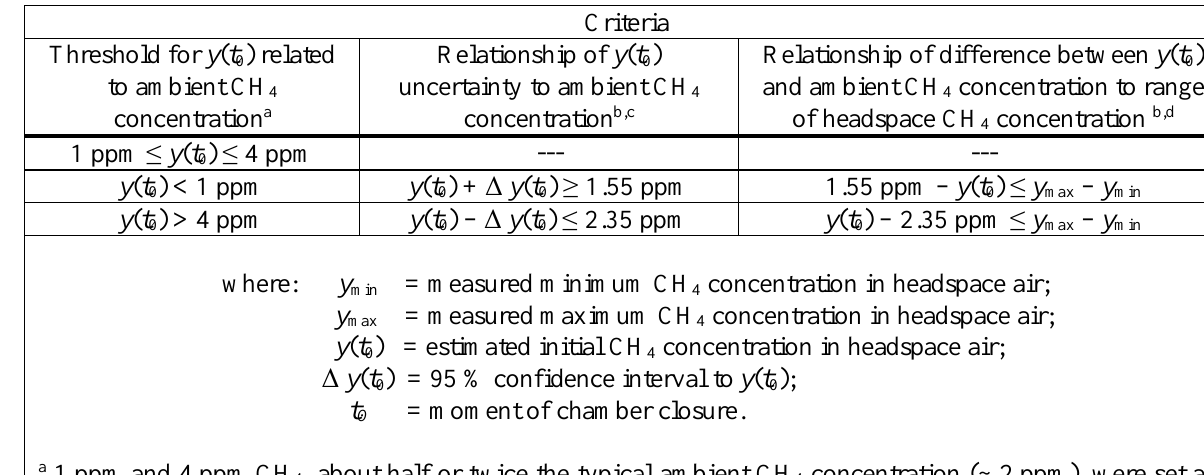
Table 4. Plausibility decisions on disturbance of flux estimation by ebullition and related criteria in headspace methane (CH 4 ) concentration time series: If all criteria within one row are fulfilled, the flux estimate is considered to be sufficiently free of disturbance by CH 4 ebullition. If in all rows at least one respective criterion is not fulfilled, the flux estimate is considered to be disturbed by CH 4